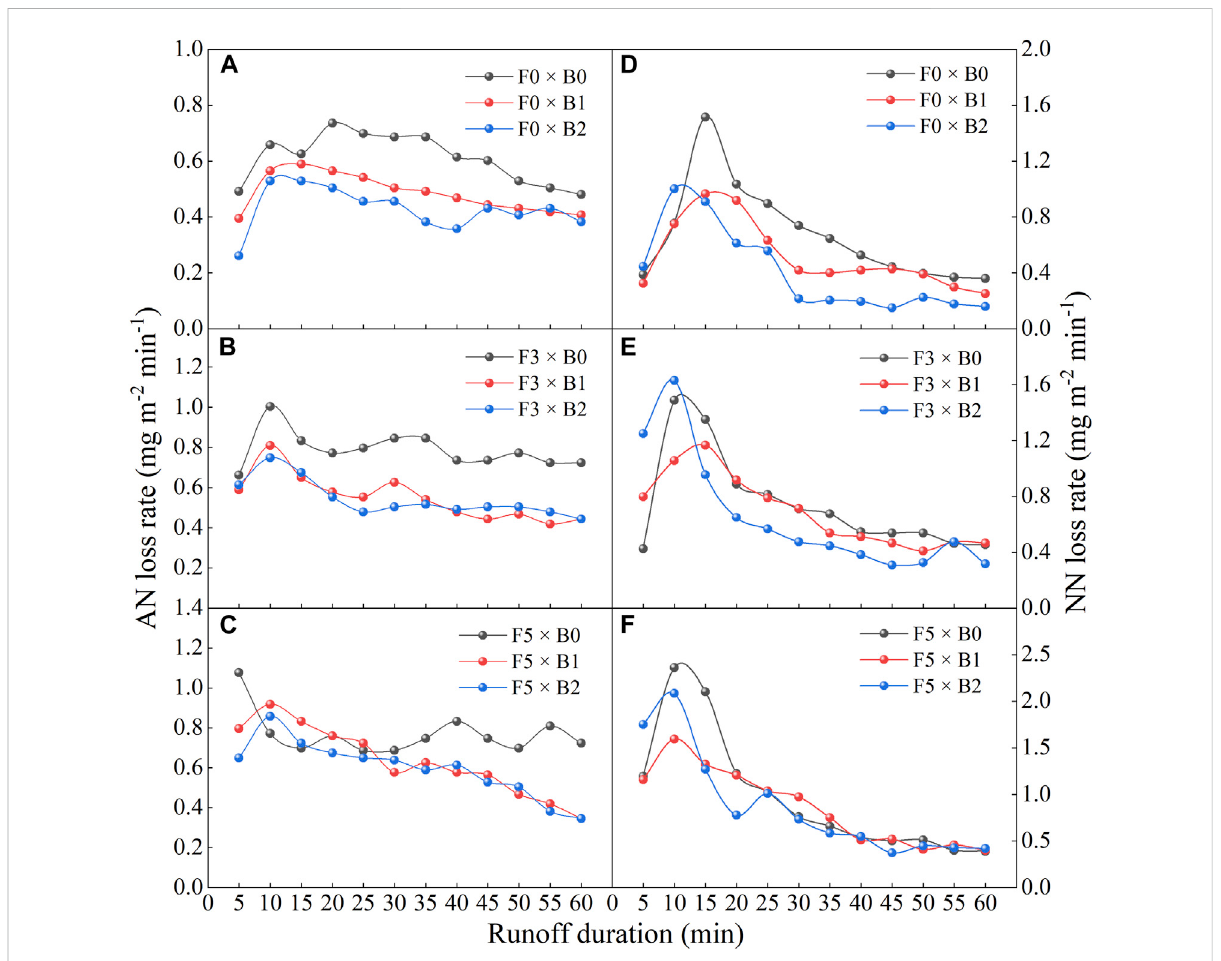
FIGURE 3 In fl uenceofbiocharapplicationrates(B0:0 kg hm − 2 ,B1:500 kg hm − 2 ,andB2:1000 kg hm − 2 )onthelossratesof (A – C) ammonianitrogen(AN) and (D – F) nitrate nitrogen (NN) under the freeze-thaw conditions (F0: 0 cycles, F3: 3 cycles, and F5: 5